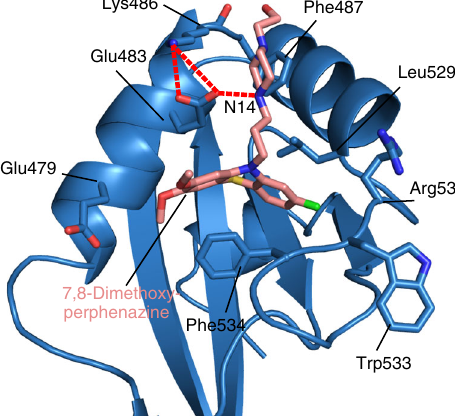
Fig. 4 Crystal structure of PUF60 UHM in complex with 7,8- dimethoxyperphenazine. Side chains are shown for residues in the binding site. 7,8-dimethoxyperphenazine is colored in salmon. A polar contact between Glu483 and the N14-amine group of the piperazine moiety is shown by a red dotted line.